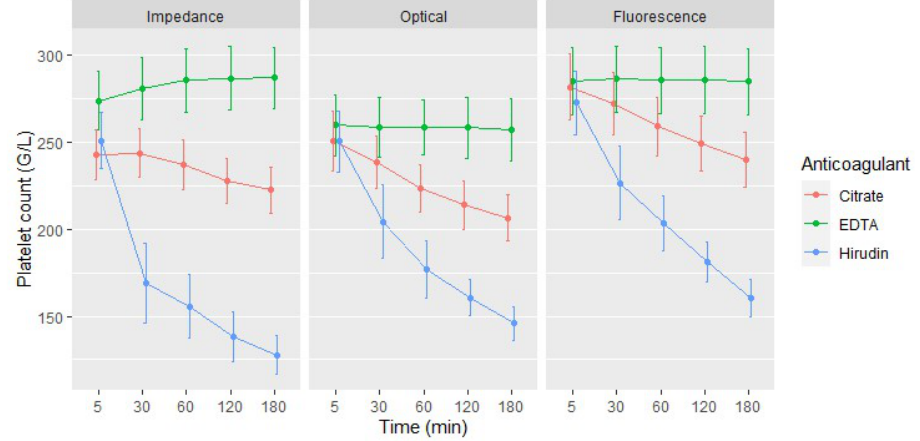
Figure 2. Mean platelet count (G / L) according to the time elapsed between blood draw and analysis. Red lines represent tests performed with blood samples anticoagulated with citrate, green lines with EDTA and blue lines with hirudin. Bars represent 95% CI of the mean.